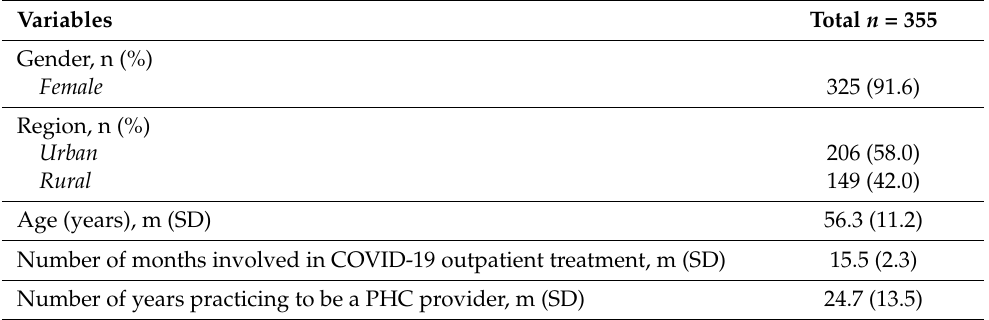
Table 2. Socio-demographic characteristics of the PHC providers who participated in the